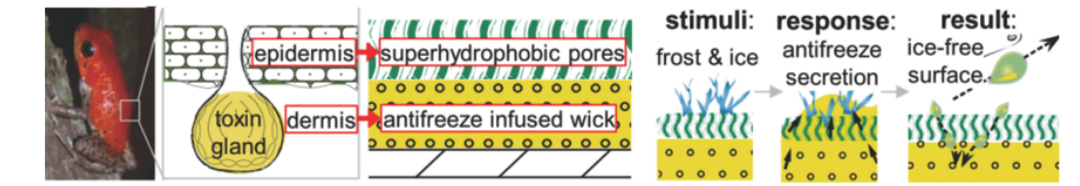
Figure 14. A two-layered coating, inspired by frog’s skin that secretes anti-freeze as a response to ice accretion. Reprinted with permission from Ref. [62]. c (cid:13) 2015 Wiley Online Library.